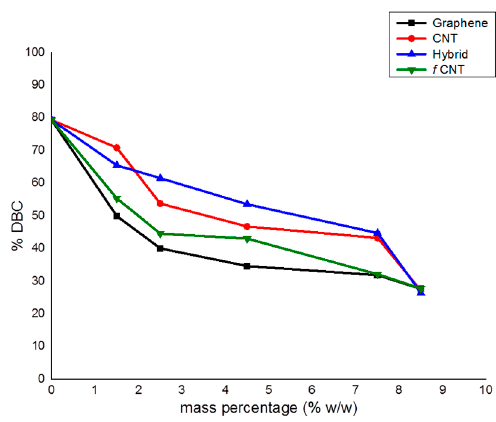
Figure 4. % DBC of the reinforced PEGDA composites in several mass percentages.